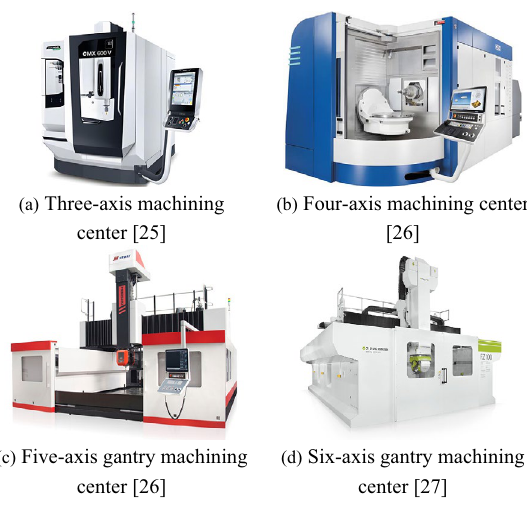
Figure 6 Mature application of manufacturing equipment: a Three-axis machining center [25]; b Four-axis machining center [26]; c Five-axis gantry machining center [26]; d Six-axis gantry machining center